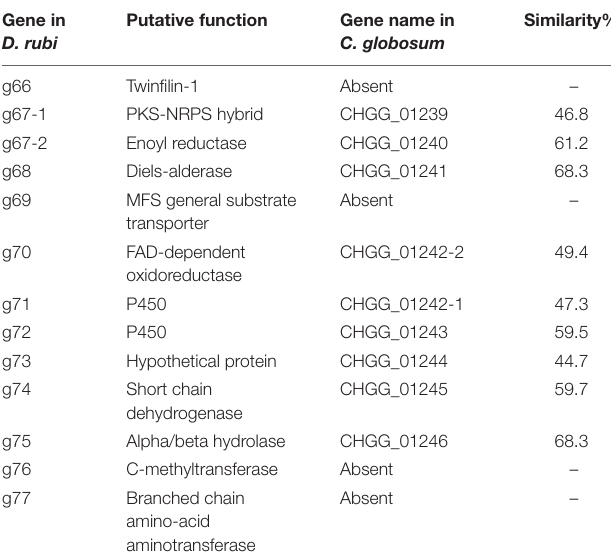
TABLE 2 | Predicted proteins from the putative chaetoglobosin P gene cluster in Discosia rubi TTI-0885 and their similarity to orthologs in the chaetoglobosin A gene cluster from Chaetomium globosum CBS